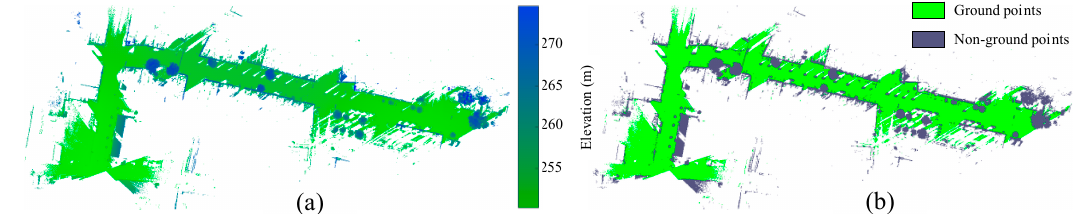
Figure 2. Data I (town scene). ( a ) Original point cloud; ( b ) Rough ground classification.